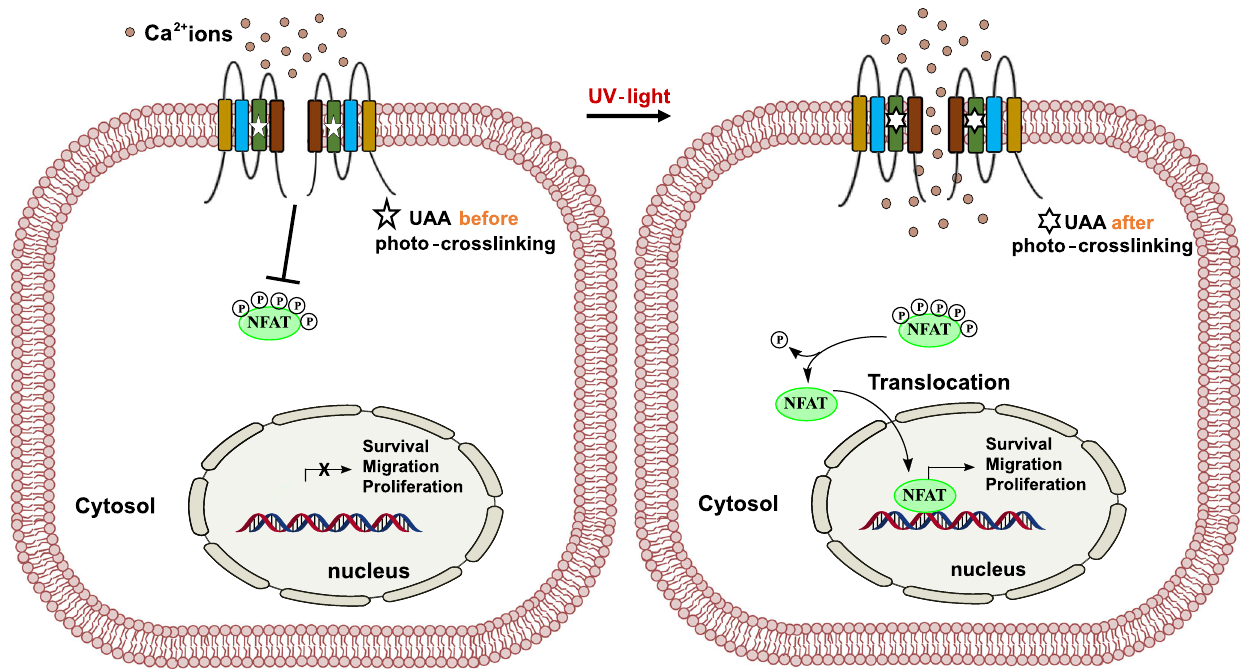
Fig.10|Photocrosslinking-inducedOrai1activationleadstoCRACchannel-like Ca 2+ in fl ux suitable to trigger nuclear factor of activated T-cells (NFAT) translocation. (left)ClosedOrai1channel(representedbytwosubunitscontaining four transmembrane (TM) domains) which has a photocrosslinking UAA (star) in one of the TM domains incorporated. (right) Upon application of UV